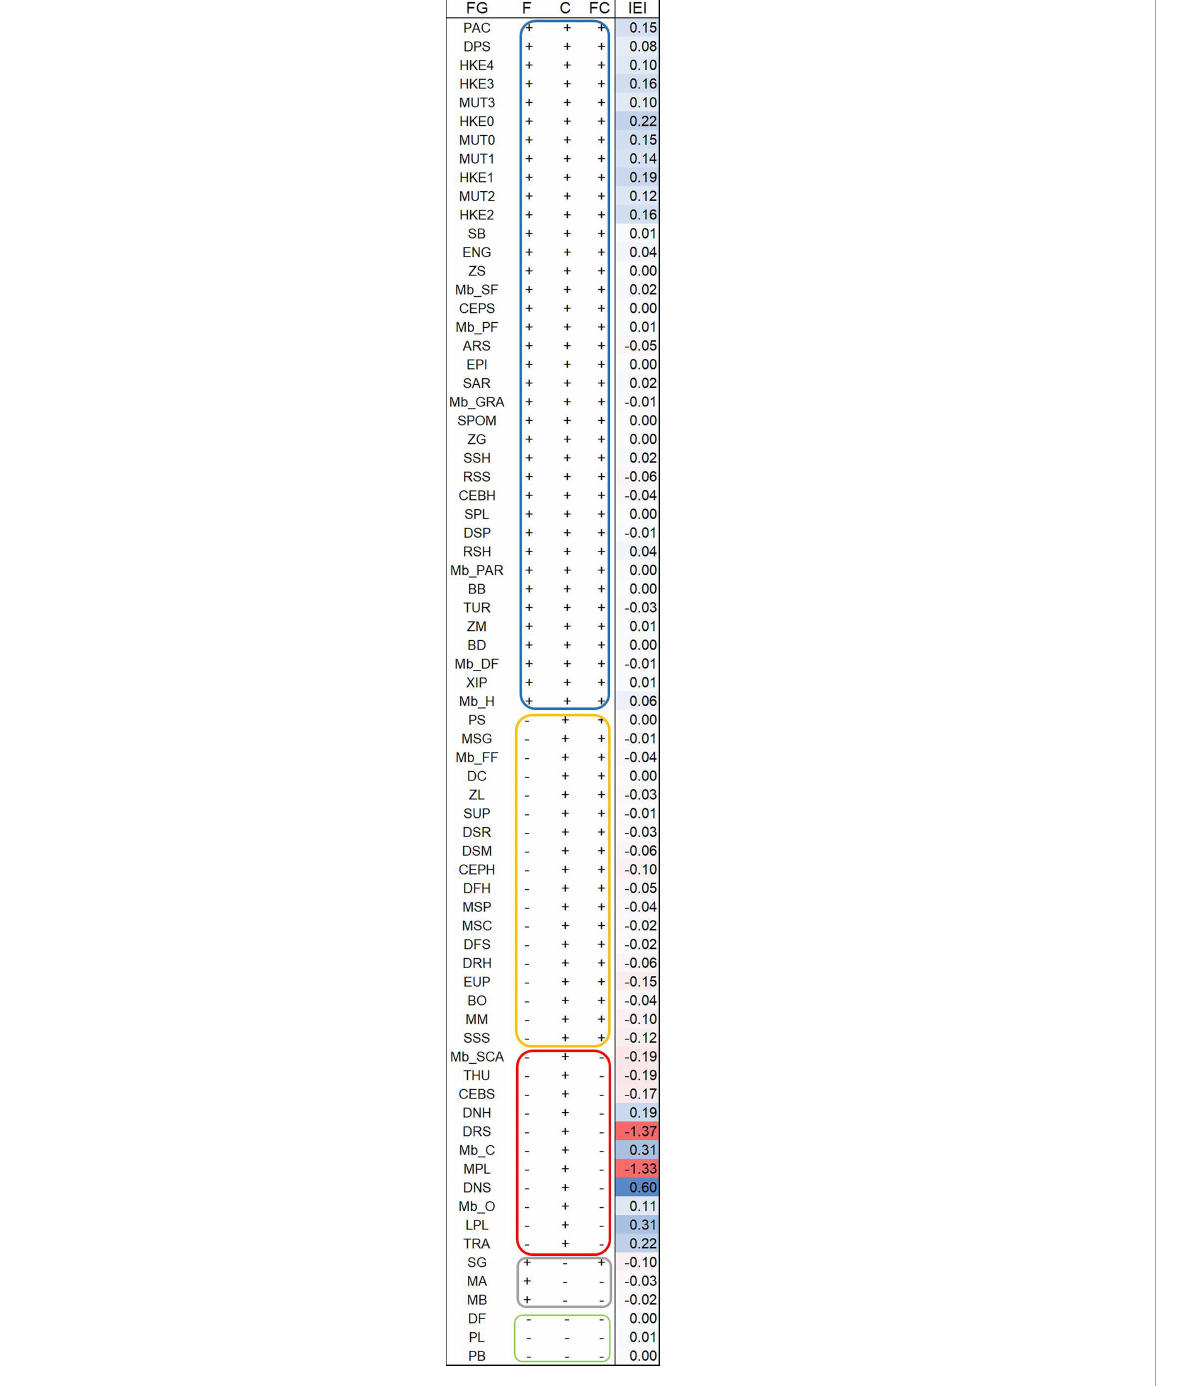
FIGURE 9 Increase (+) or decrease (-) in mean ratio (2046-2050) of functional group (FG) biomass was evaluated as an FG response to the different scenarios and used for a qualitative clustering. In each cluster, FGs are in ascendant order by considering a cumulative response (algebraic sum of mean ratio) across scenarios. Interactive Effect Index (IEI) is given to show synergistic (blue) and antagonistic (red) effect between effort reduction and climate on